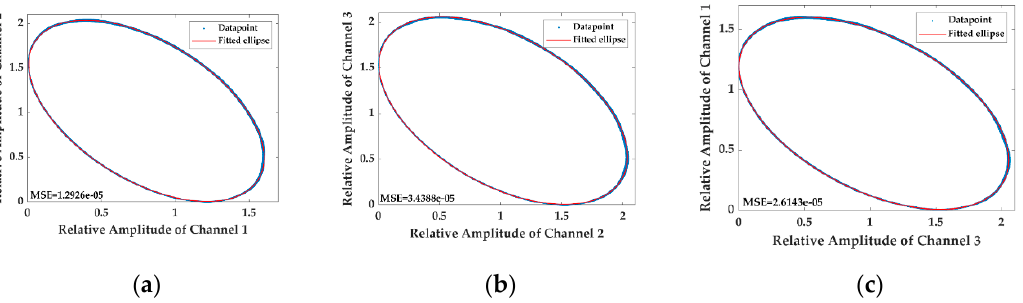
Figure 6. The LPs drawn with the processed interferometric signals and the fitted ellipses. ( a ) The LF plotted with the relative amplitude of Channel 1 and Channel 2 as well as the fitted ellipse; ( b ) the LF plotted with the relative amplitude of Channel 2 and Channel 3 as well as the fitted ellipse; ( c ) the LF plotted with the relative amplitude of Channel 3 and Channel 1 as well as the fitted ellipse.